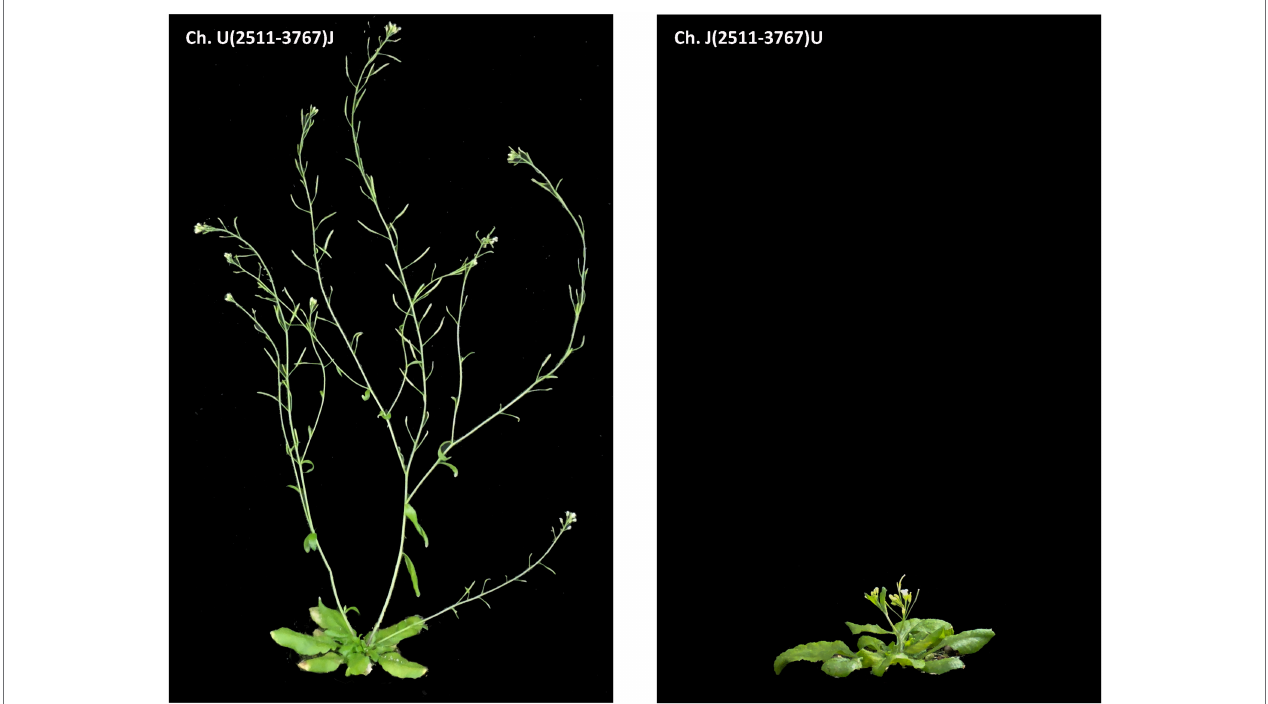
FIGURE 4 | Phenotypes of Arabidopsis plants inoculated with viral chimeras (Sánchez et al., 2015) between TuMV isolates UK 1 and JPN 1, centered in the P3 region of the viral genome. The chimeras used for inoculation are shown in the